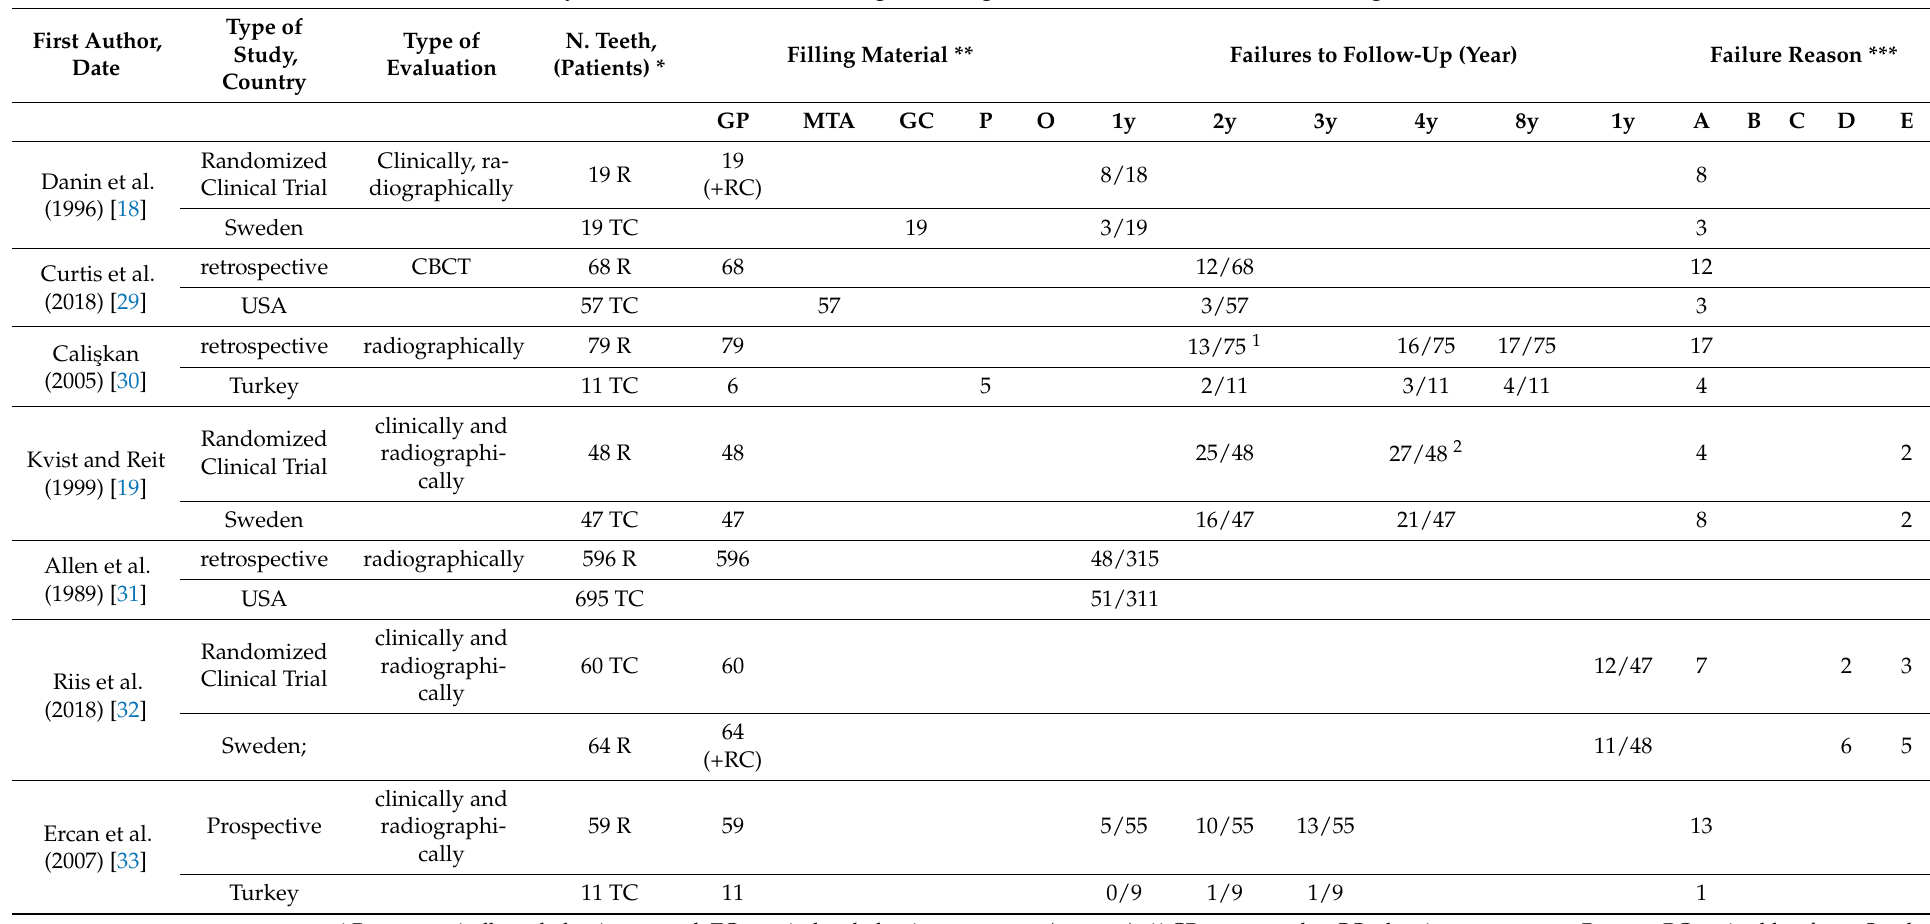
Table 2. Complete list of studies included in the